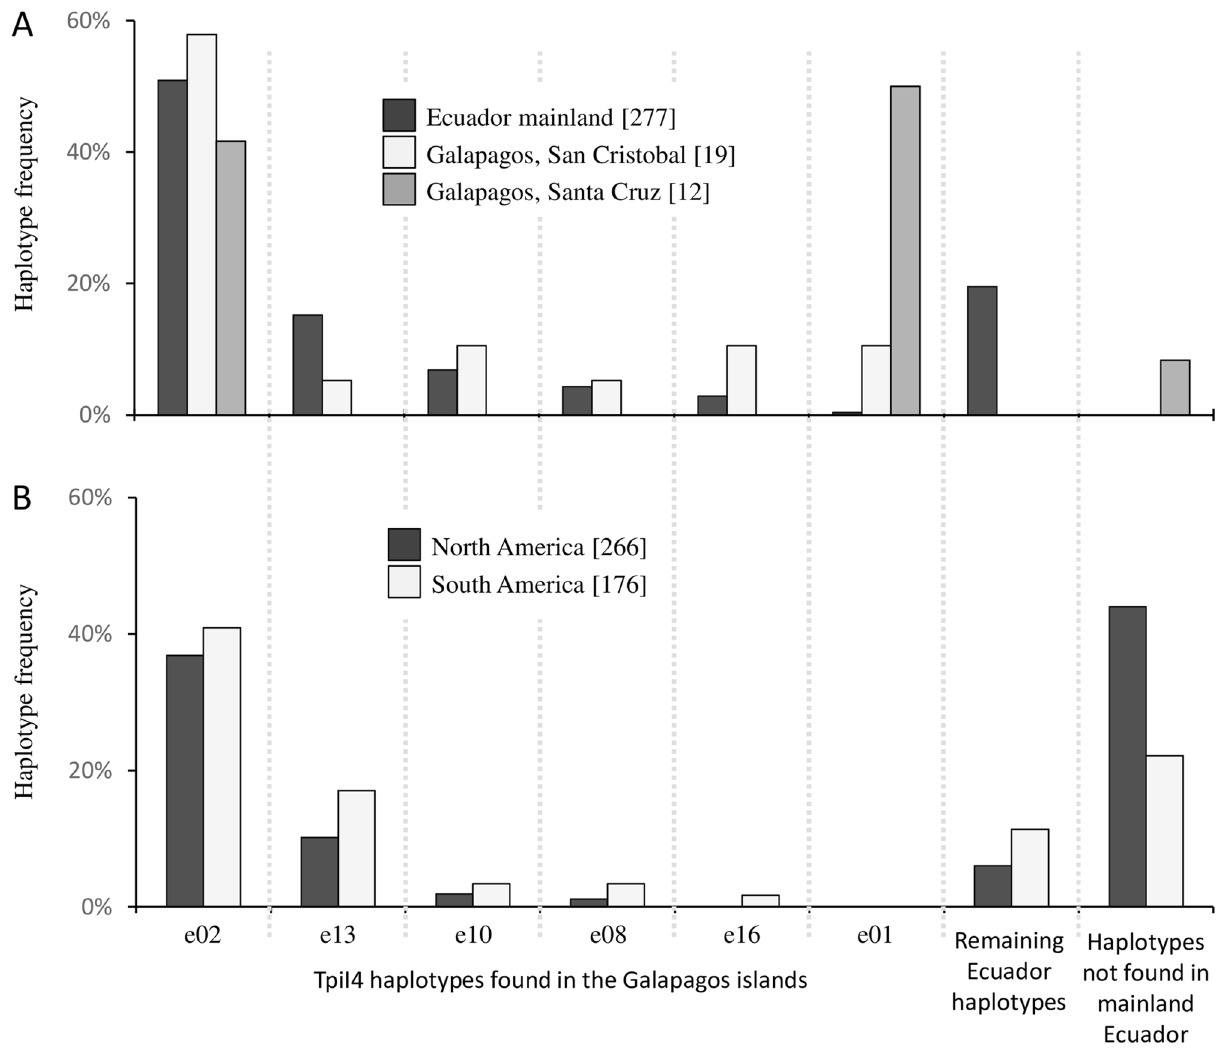
Figure 5. Bar graph showing frequencies of the TpiI4 haplotypes found in Ecuador in different collections. The number of sequences examined is in brackets. The X-axis lists haplotype categories found in mainland Ecuador including four also found in the Galápagos. The mainland Ecuador haplotypes not found in the Galápagos are pooled. The final category is made up of haplotypes not found in Ecuador but detected elsewhere. ( A ) Comparisons of haplotype data from mainland Ecuador and the Galápagos. ( B ) Comparisons of mean haplotype frequencies from Florida and Texas (North America) and Peru, Bolivia, Argentina, and Brazil (South